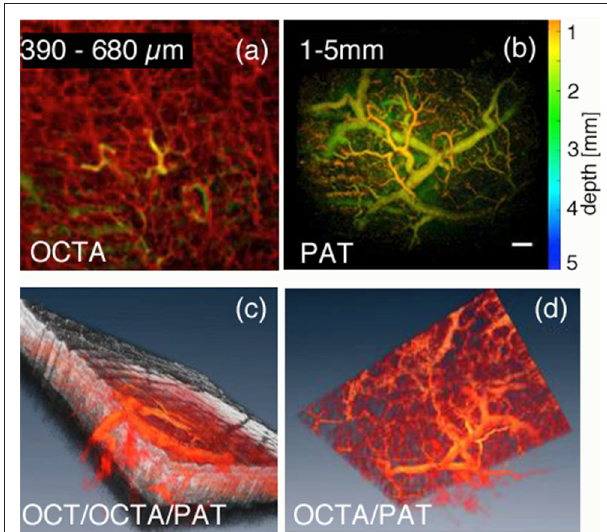
FIGURE 5 | Combined OCT/OCTA and PAT for depth enhanced visualization of skin perfusion, (a) Maximum intensity projected OCTA for superficial capillary beds; The yellow vessel structures appear both in OCTA and PAT and are used for volume co-registration. (b) Color coded depth PAT for deeper vascular structures; (c) volume rendered view of combined OCT (gray) and OCT/PAT (red); (d) volume rendered view of combined OCTA and PAT. Scale bar is 500 µ m. Modified from Liu et al. [149] with permission from